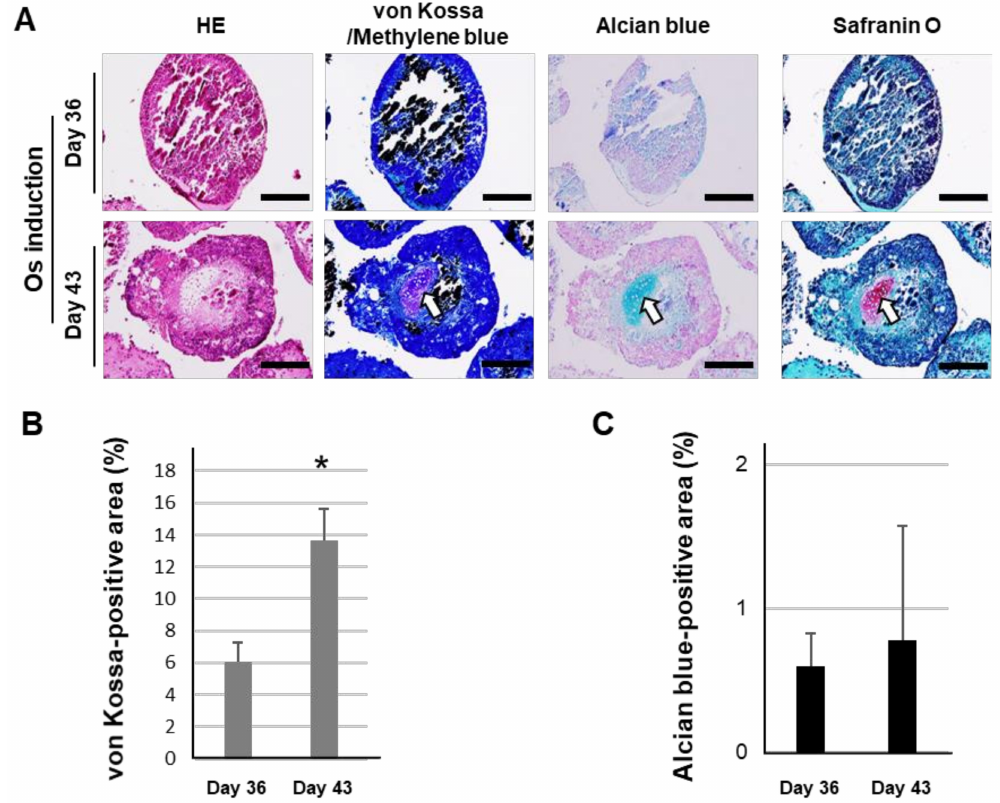
Figure 2. E ff ects of Os induction on mineralization and cartilage formation in osteogenically induced iPSC (OI-iPSC) constructs. ( A ) Representative images of histochemical staining of OI-iPSC constructs on days 36 and 43 by hematoxylin and eosin (HE), von Kossa (methylene blue-counterstain), alcian blue and safranin O. Arrows indicate cartilage-like tissues. Scale bars; 200 µ m. Histomorphometric analysis of ( B ) von Kossa staining-positive (black stained) areas and ( C ) alcian blue-positive areas in the sections. The data represent the mean ± SD (B and C; n = 5). Asterisks indicate significant di ff erences between groups ( p < 0.05, Student’s t